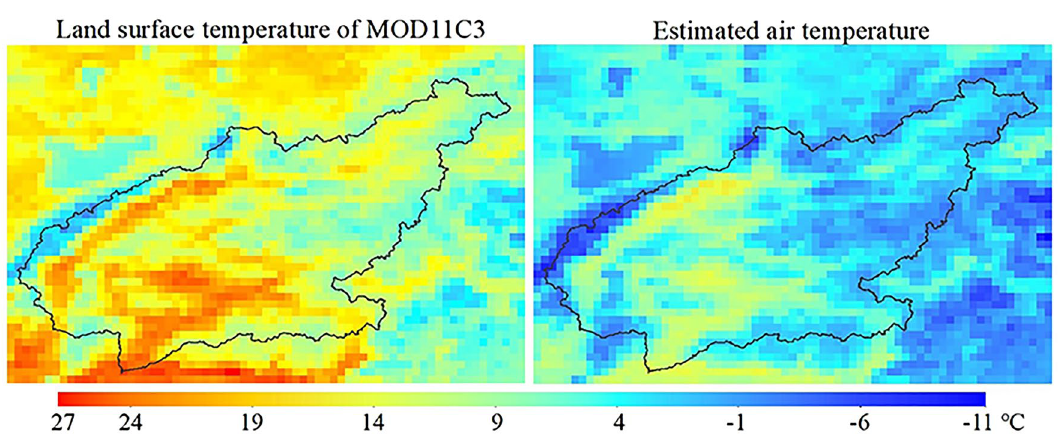
Figure 4. Distribution maps of monthly average temperature between 2001 and 2015 with 0.05°